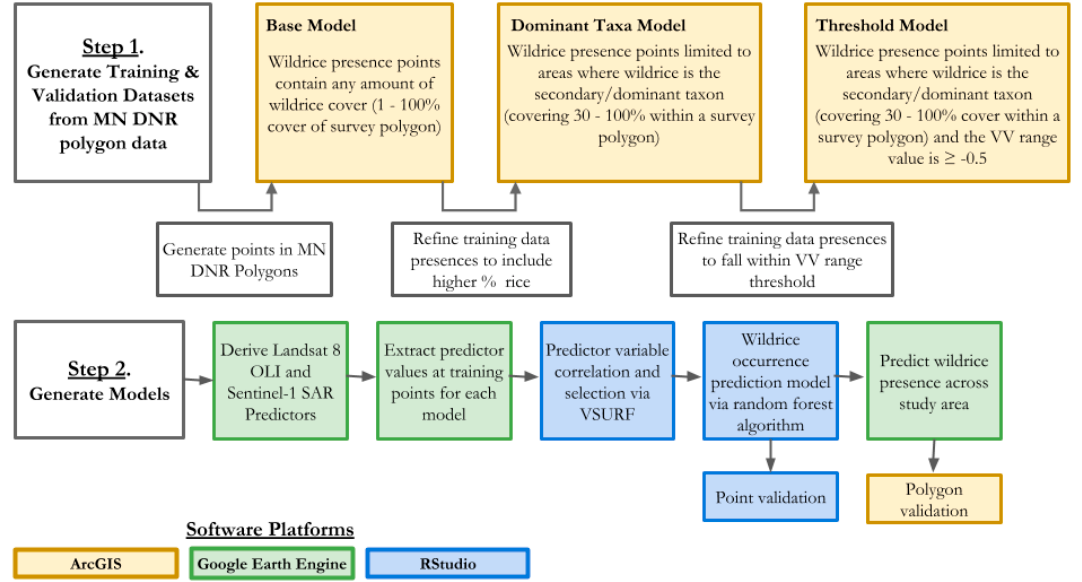
Figure 2. Flowchart that illustrates and describes the refinement of training and validation data that characterizes each of the three wildrice models (Base Model, Dominate Taxa Model, and Threshold Model), the modeling process to map wildrice, and the model validation.